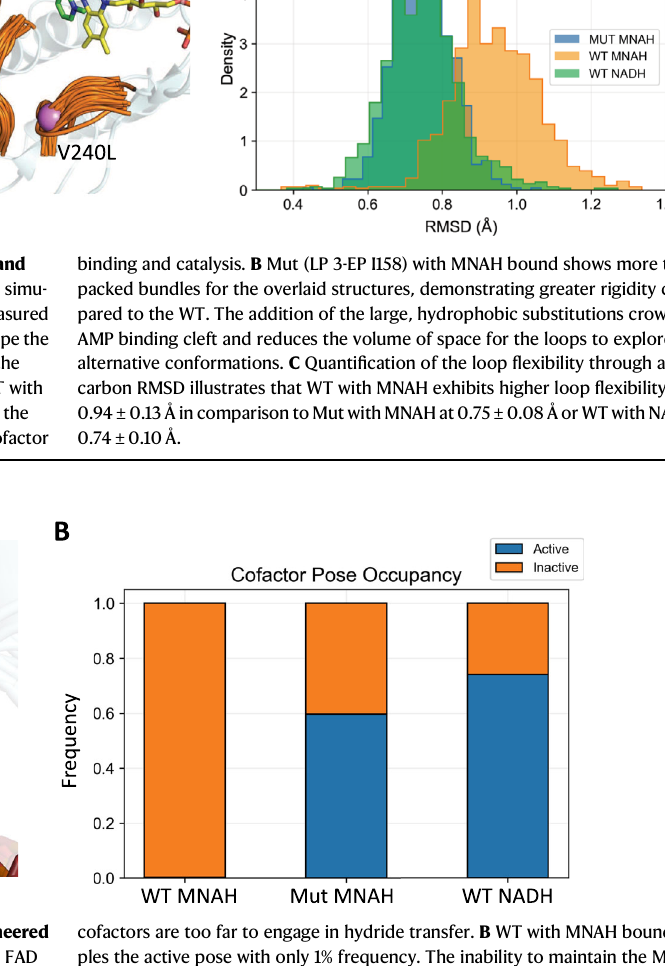
cofactors are too far to engage in hydride transfer. B WT with MNAH bound sam- ples the active pose with only 1% frequency. The inability to maintain the MNAH withinhydridetransferdistanceisresolvedintheMut(LP3-EPI158)whichsamples the active pose at 60% frequency. The WT Lp Nox fi rmly anchors the native NADH through the AMP handle and occupies the active pose in 74% of the